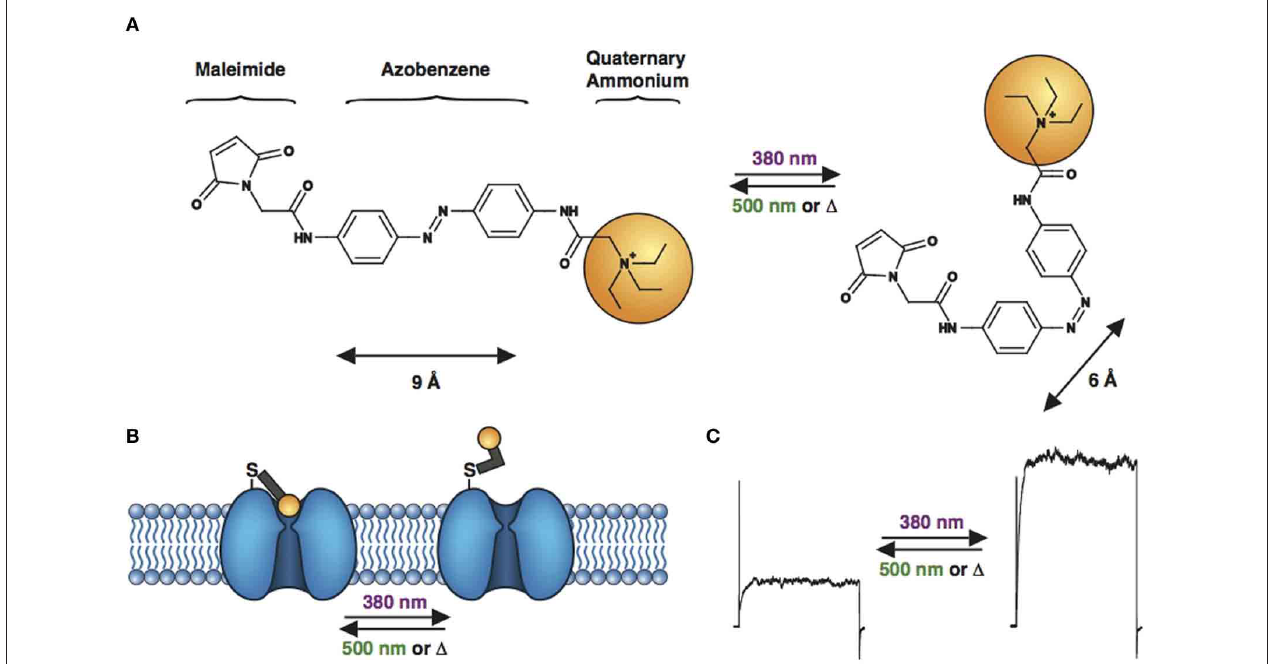
attached on an engineered cysteine located on the extracellular surface of a K + channel. In the extended trans configuration (dark or 500nm light), MAQ blocks ion conduction. Photoisomerization to cis with 380nm light shortens MAQ and relieves block. (C) Current through a photoswitchable Kv3.1 channel labeled with MAQ, under both wavelengths of